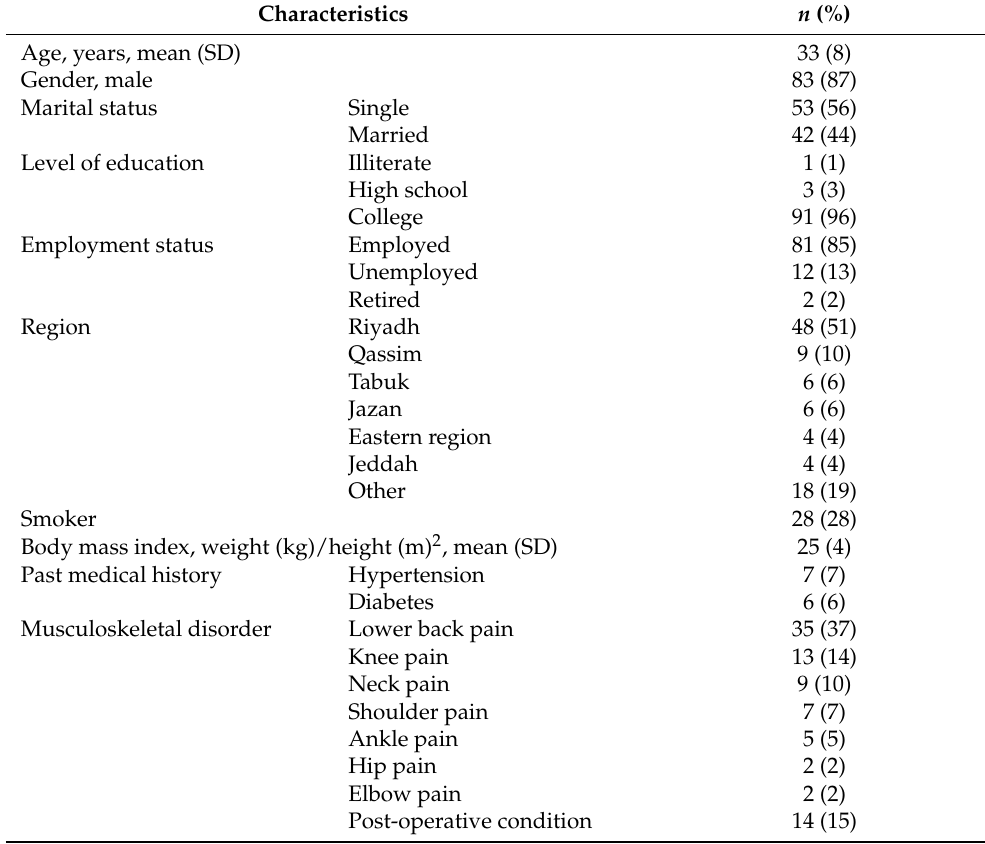
Table 1. Participants’ demographic and descriptive data ( n =